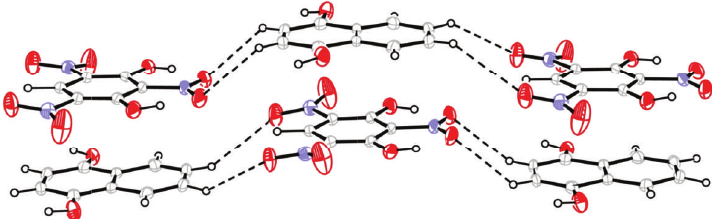
Figure 5: The view of infinite polymeric chains along the 𝑎 axis. Also, C8–H8 ⋅⋅⋅ O1 iv and C9–H9 ⋅⋅⋅ O3 iv at −𝑥 , −𝑦+1 , −𝑧+1 intermolecular hydrogen bonds form infinite polymeric chain along the 𝑏 axis (Figure 6, Table